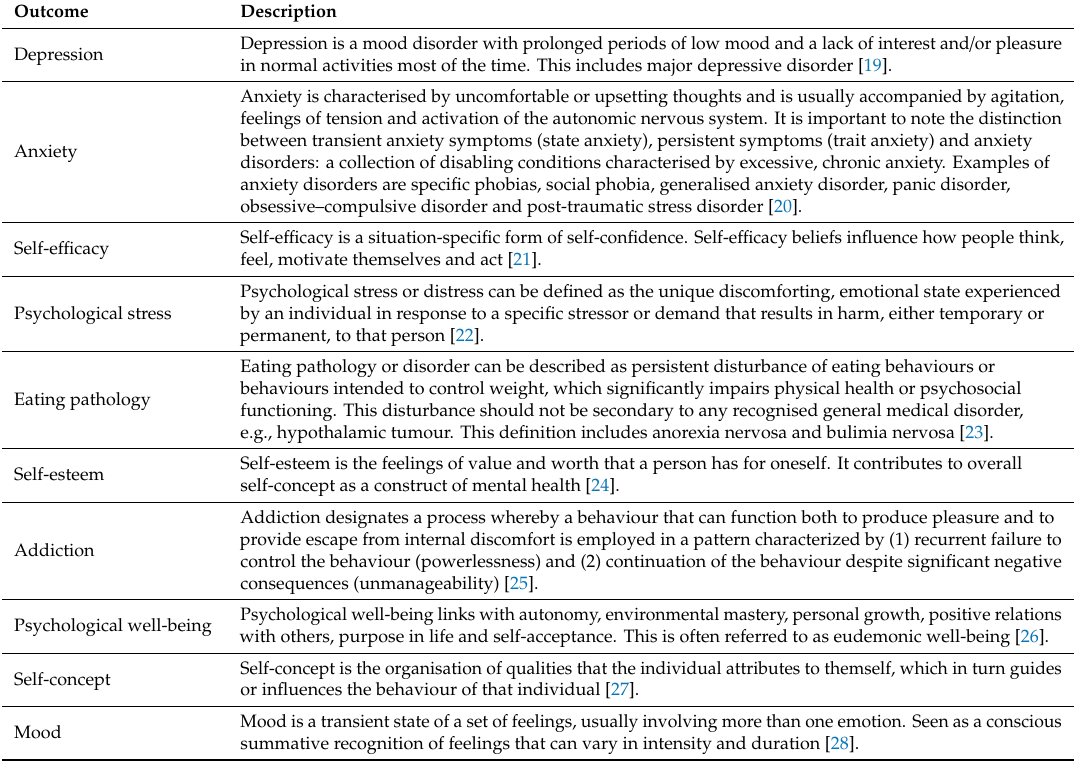
Table 1. Definitions of the mental health outcomes included within the review: the outcomes were informed by Kelly et al. (2018) [8]. Outcome Description Depression Anxiety is characterised by uncomfortable or upsetting thoughts and is usually accompanied by agitation, feelings of tension and activation of the autonomic nervous system. It is important to note the distinction between transient anxiety symptoms (state anxiety), persistent symptoms (trait anxiety) and anxiety Anxiety disorders: a collection of disabling conditions characterised by excessive, chronic anxiety. Examples of